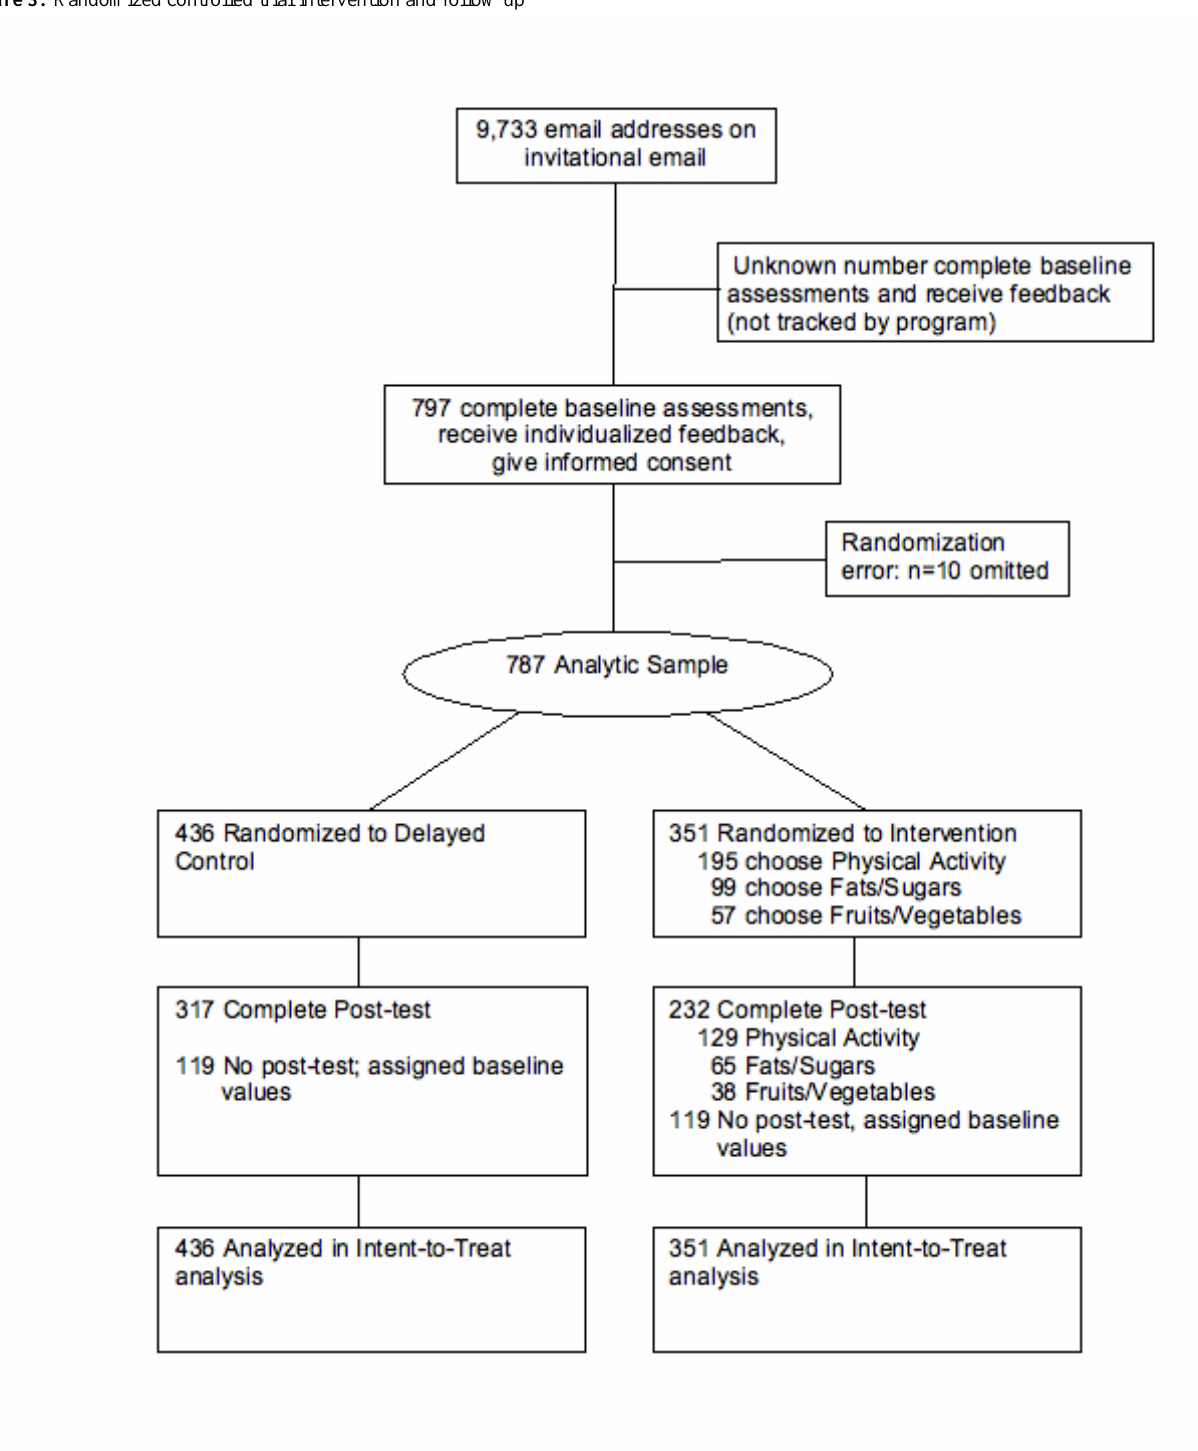
Figure 3. Randomized controlled trial intervention and